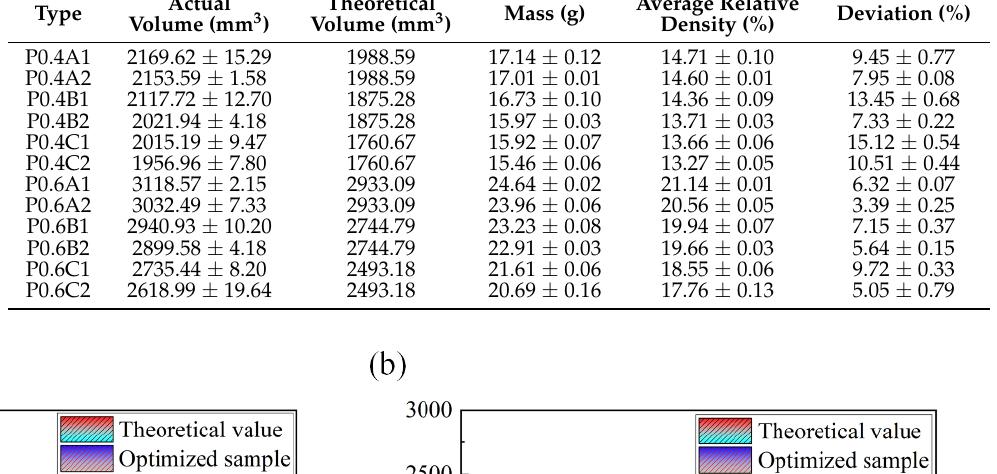
Table 3. Volume, mass, and densities of samples.